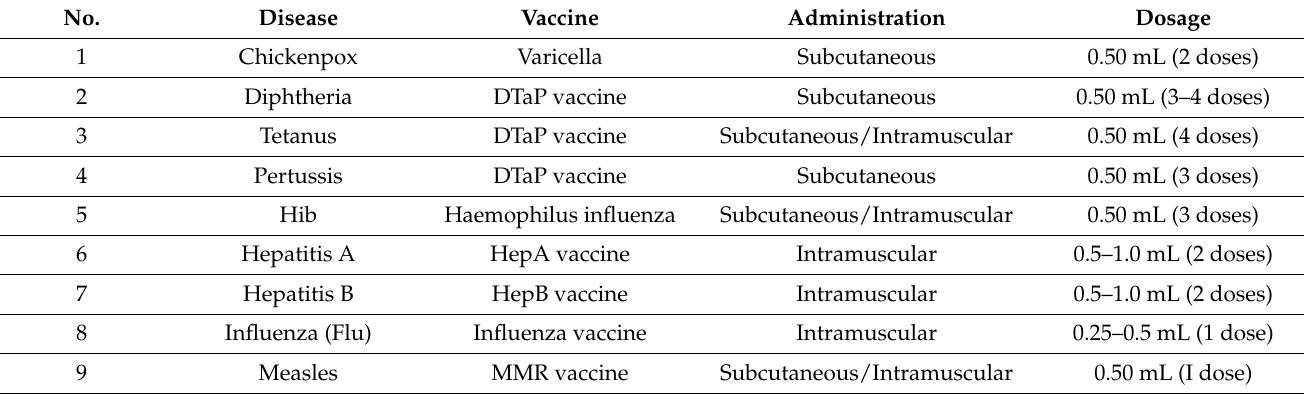
Table A1. Various diseases, their drug dosage limits, and administration